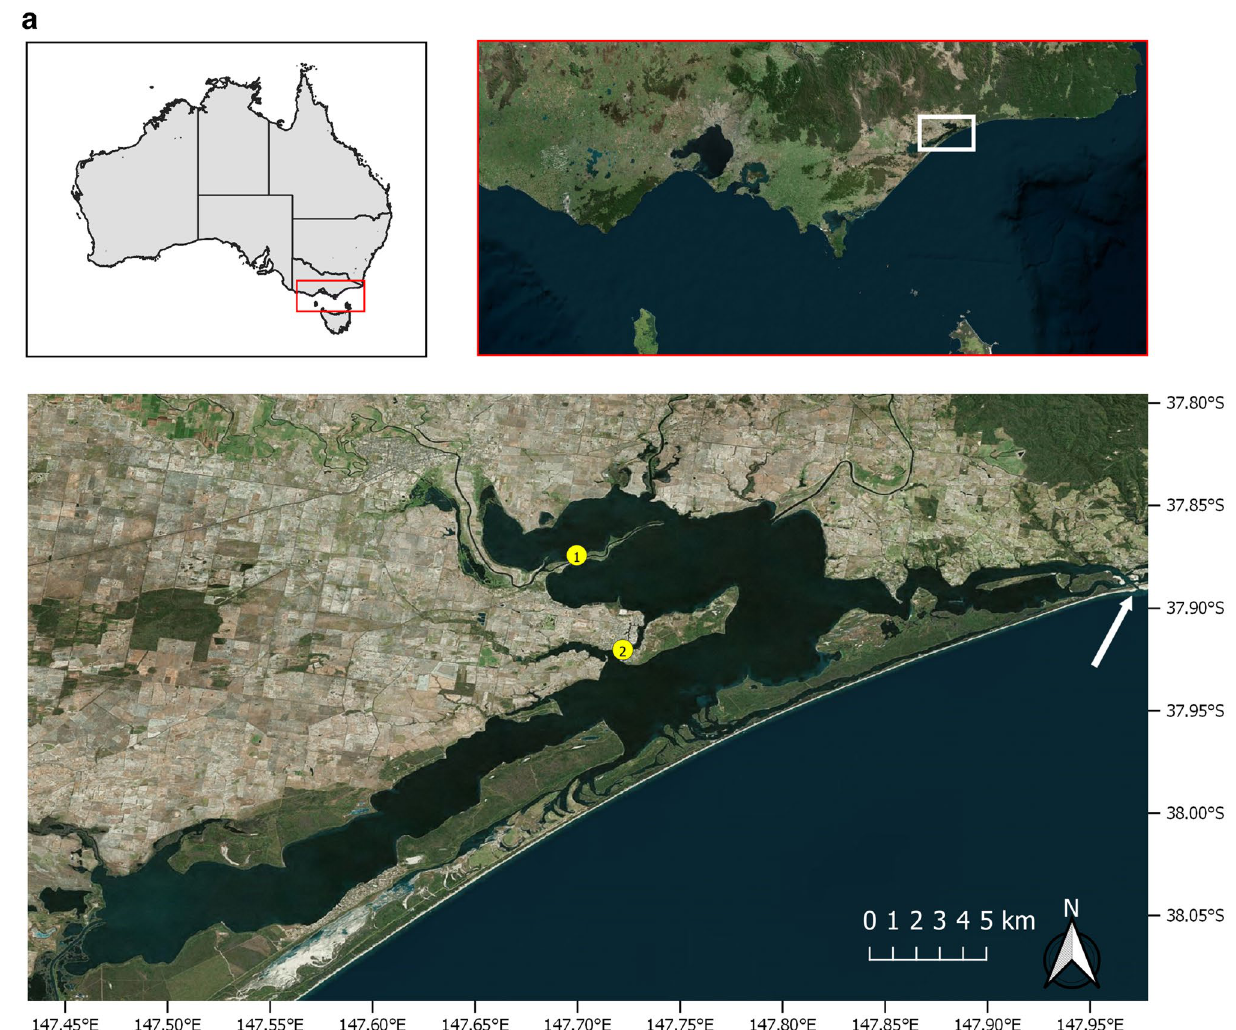
Figure 1. ( a ) The red and white rectangles show the location of the Gippsland Lakes in eastern Victoria, Australia (upper maps). The lower map shows the stranding locations (yellow dots) on Lake King for the adult female Tursiops australis (Case 1) found dead 29th Oct. 2007, carcass code 2 (fresh). The adult male T. australis (Case 2) was found 1st Nov. 2007, carcass code 2. The arrow indicates Lakes Entrance where the lakes opens to the Tasman Sea. Maps were produced using QGIS v3.10.11 (with Bing aerial insert). QGIS Geographic Information System, Open Source Geospatial Foundation Project. http://qgis.org. ( b ) The red and white rectangles show the location of the Swan-Canning river system in Western Australia. The lower map shows the stranding locations (yellow dots) for two Tursiops aduncus found dead with severe ulcerative dermatitis and the location of a third dolphin (green dot) not retrieved for necropsy. The white arrow indicates The Narrows Bridge. (3) Adult female found dead 17 Sept. 2009 (Case 3). Carcass code 2 (fresh). (4) Adult female observed agonal 25 Oct. 2009 (Case 4). Carcass code 2 (fresh). Maps were produced as for ( a